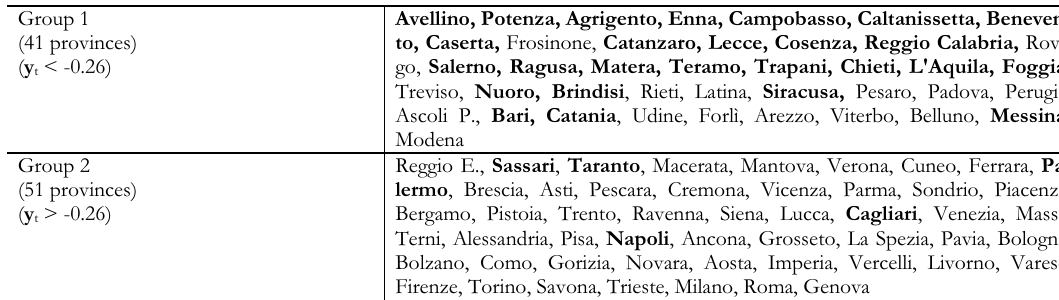
Multiple Regimes (Southern provinces are given in bold letters) Periods 1951-1970 and